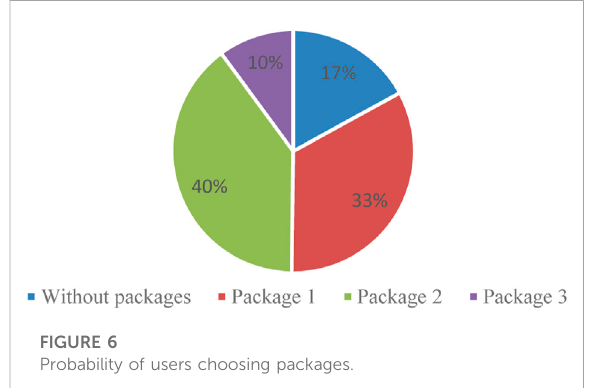
FIGURE 6 Probability of users choosing packages.